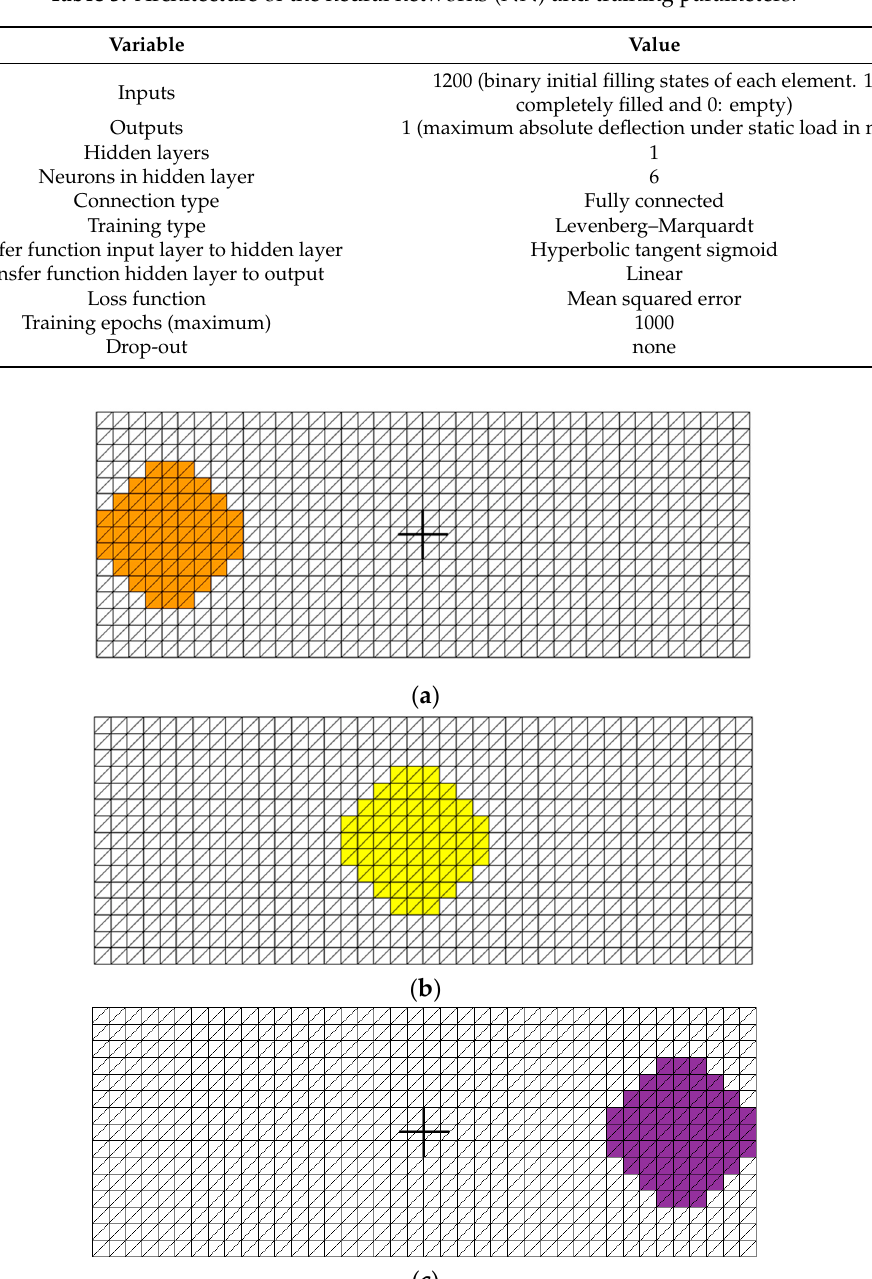
Table 3. Architecture of the neural networks (NN) and training parameters.